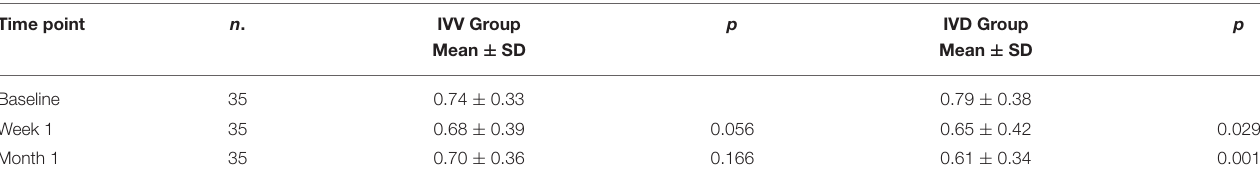
TABLE 2 | Mean BCVA (logMAR) at baseline and at subsequent time points in the two groups. Time point n